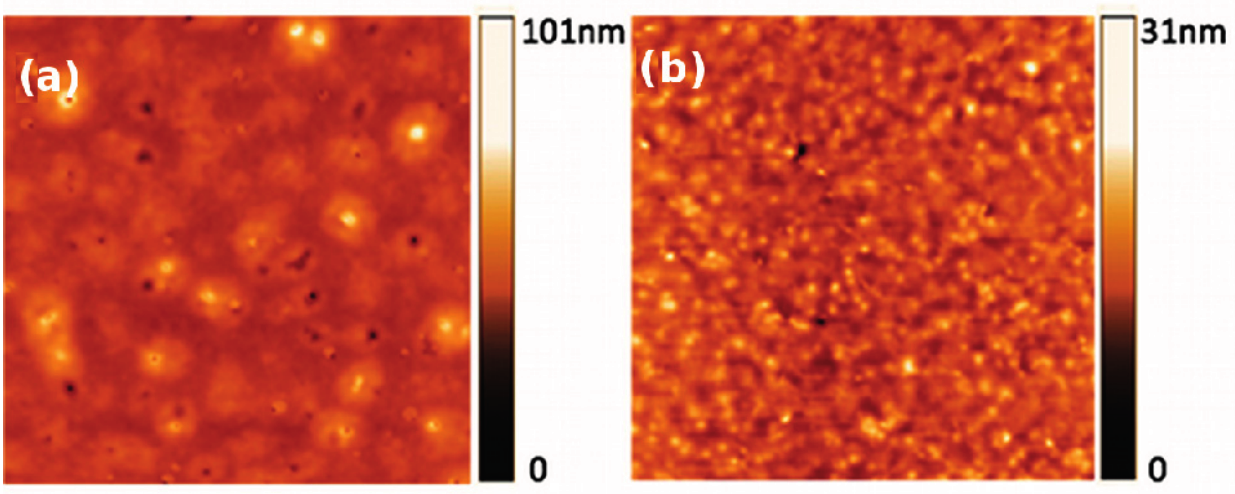
Figure 6. Atomic force microscopy (AFM) images showing the surface morphology of films ( a ) 3 and ( b ) 4 . Image sizes are 10 × 10 μ m.